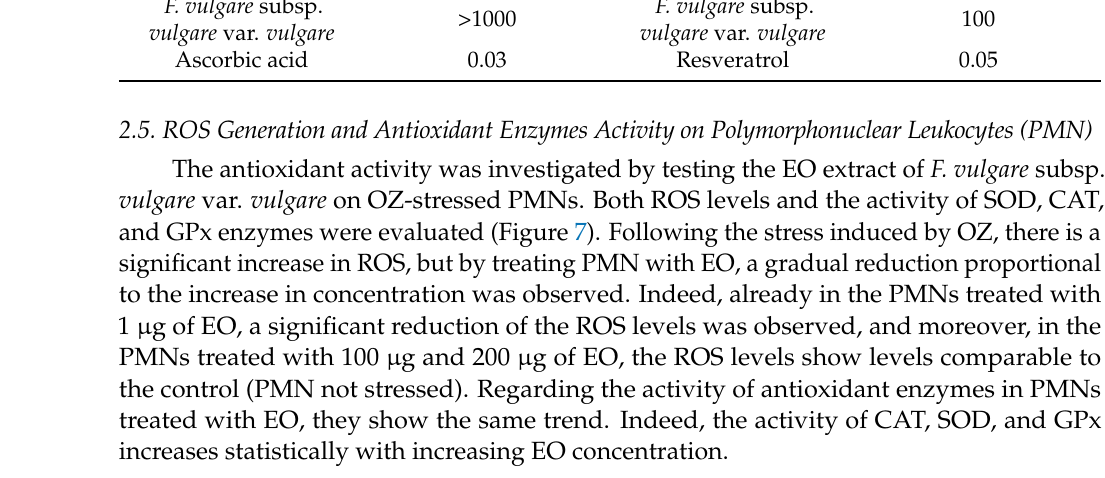
Table 2. Representation of the IC 50 : Inhibiting Concentration Free Radical at 50%. ABTS: 2,20-az- ino-bis (3-ethyl-benzothiazoline-6-sulfonic acid); H 2 O 2 : hydrogen peroxide. The positive control is ascorbic acid for ABTS; and resveratrol for H 2 O 2 .